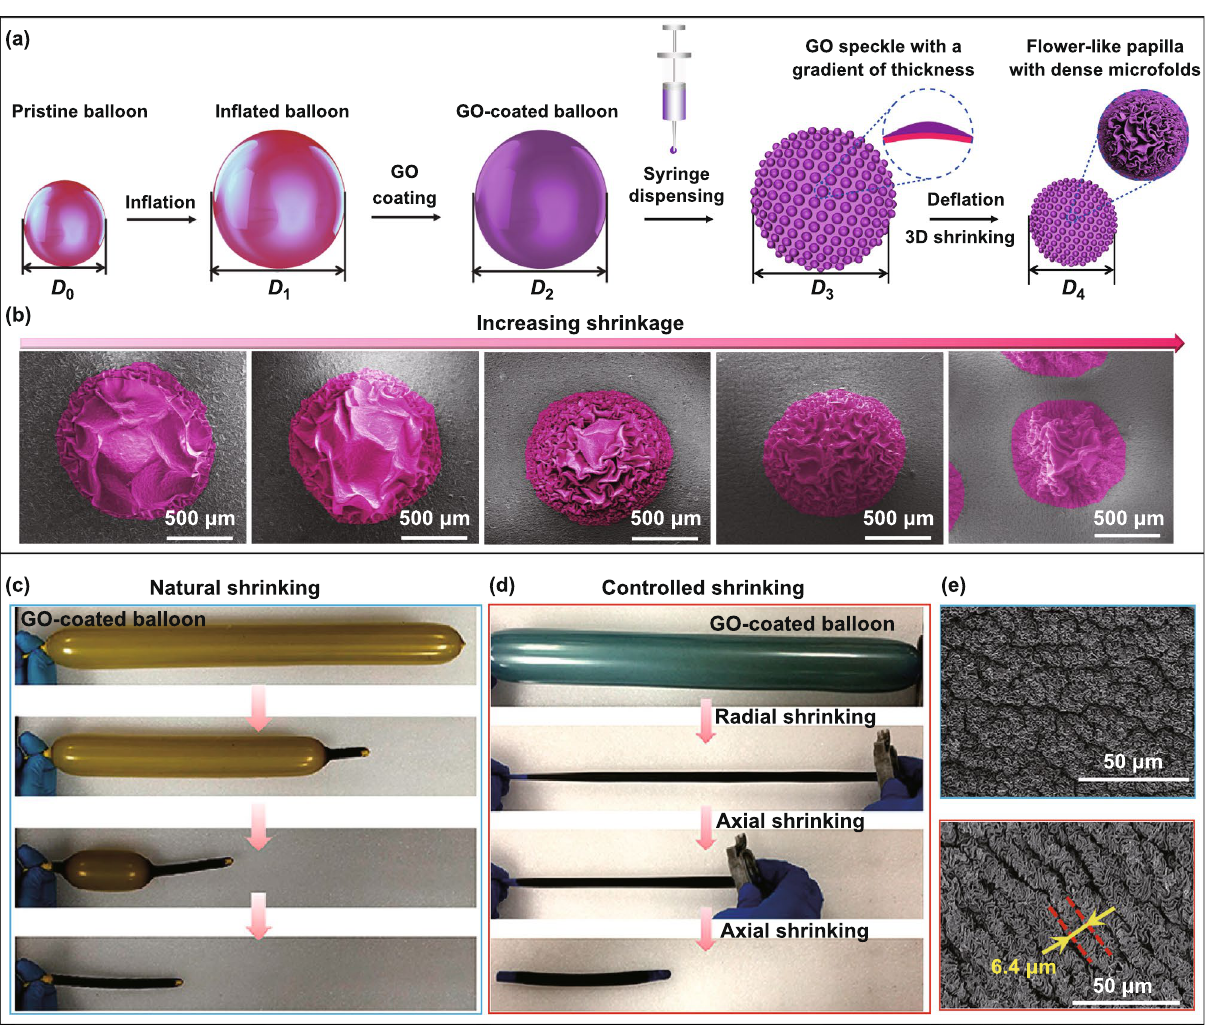
Fig. 10 Fabrications of highly convoluted patterns on hollow core–shell spheres and core–shell cylinders by inflation/deflation approach. a Schematics of the fabrication process for wrinkled papillae. b SEM images with fake colours showing the wrinkling morphology evolution of the papillae with increasing the shrinkage [54]. Copyright 2019 Wiley. c , d Fabrication of various hierarchical graphene oxide (GO) ridges on tubular balloons by natural shrinking and controlled shrinking. e SEM images show random and ordered hierarchical ridging patterns under natural shrinking (blue) and controlled shrinking (red) [61]. Copyright 2019 American Chemical Society. (Color figure